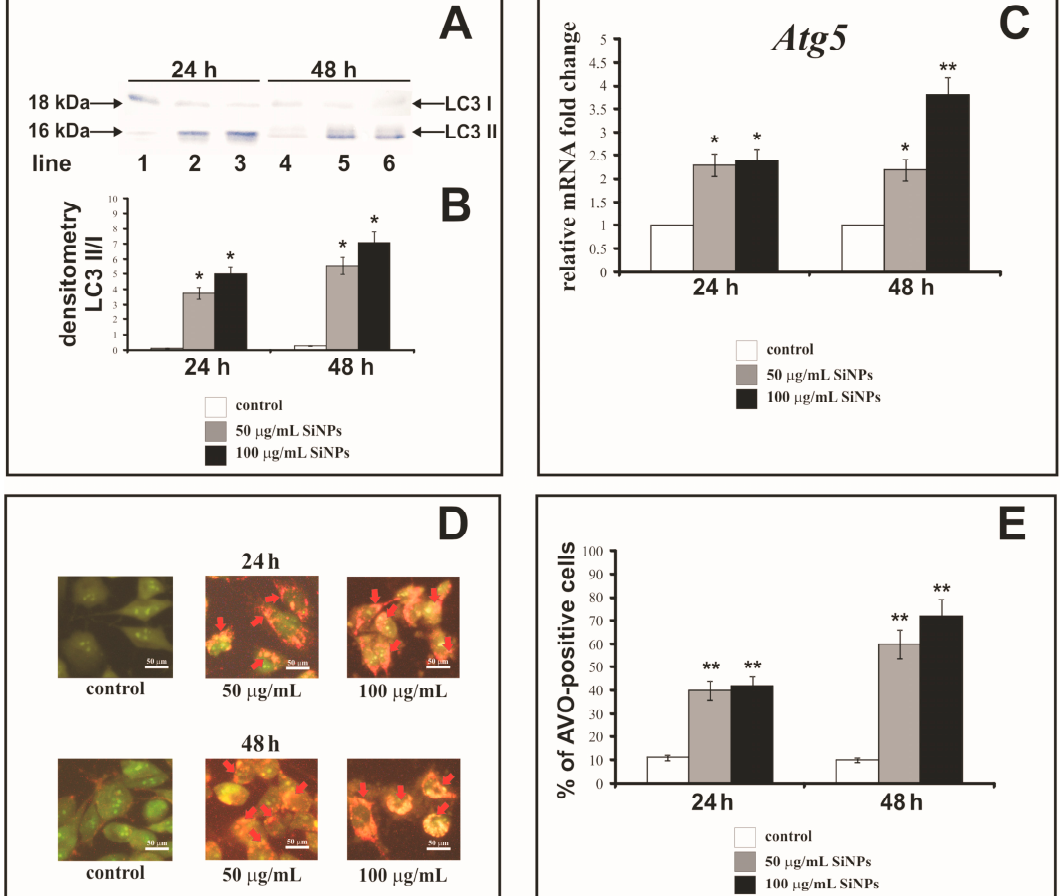
of LC3-II form, and only week expression of LC3-I. Moreover, we observed that the expression of membrane-bound LC3-II, (the phosphatidylethanolamine-conjugated form) was increased in cells incubated with 50 µ g/mL (lanes: 2, 5) and 100 µ g/mL (lanes: 3, 6) of SiNPs after 24 and 48 h in comparison to the control cells (lanes: 1, 4). Next, we conducted densitometry analysis and calculated LC3-II/LC3-I ratio (Figure 6B). We noticed time- and dose-dependent increase of LC3-II/LC3-I ratio in cells incubated with both concentrations of SiNPs.